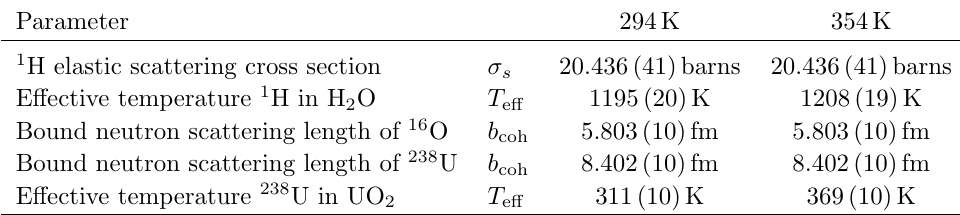
Table 2. Model parameters and uncertainties used in this work.